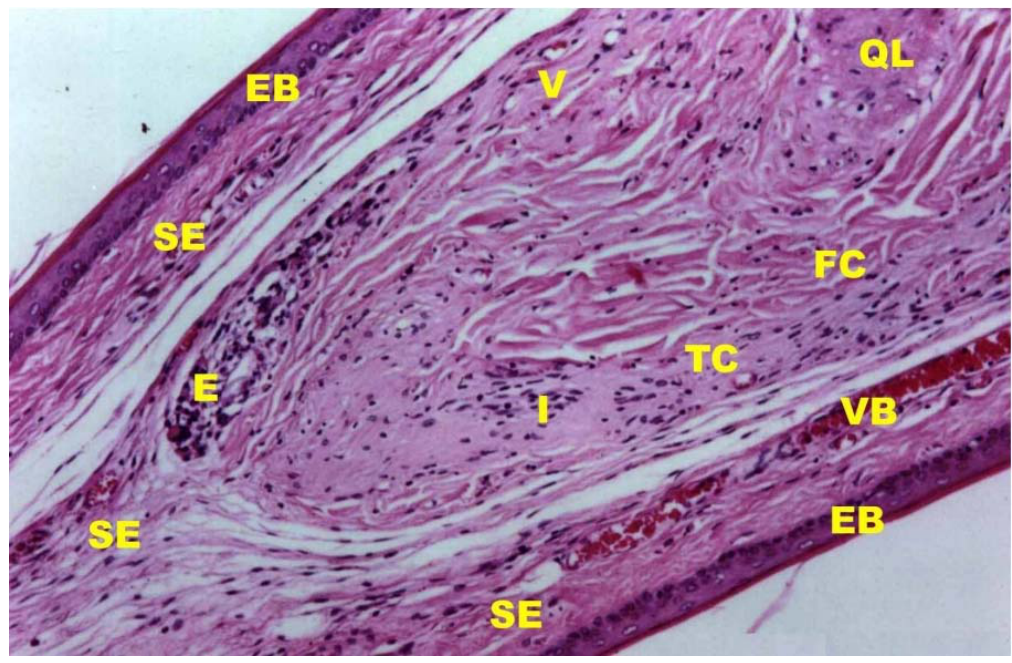
FIGURE 6 – Microscopic aspect of the keloid fragment grafted in hamster cheek pouch after 5 days